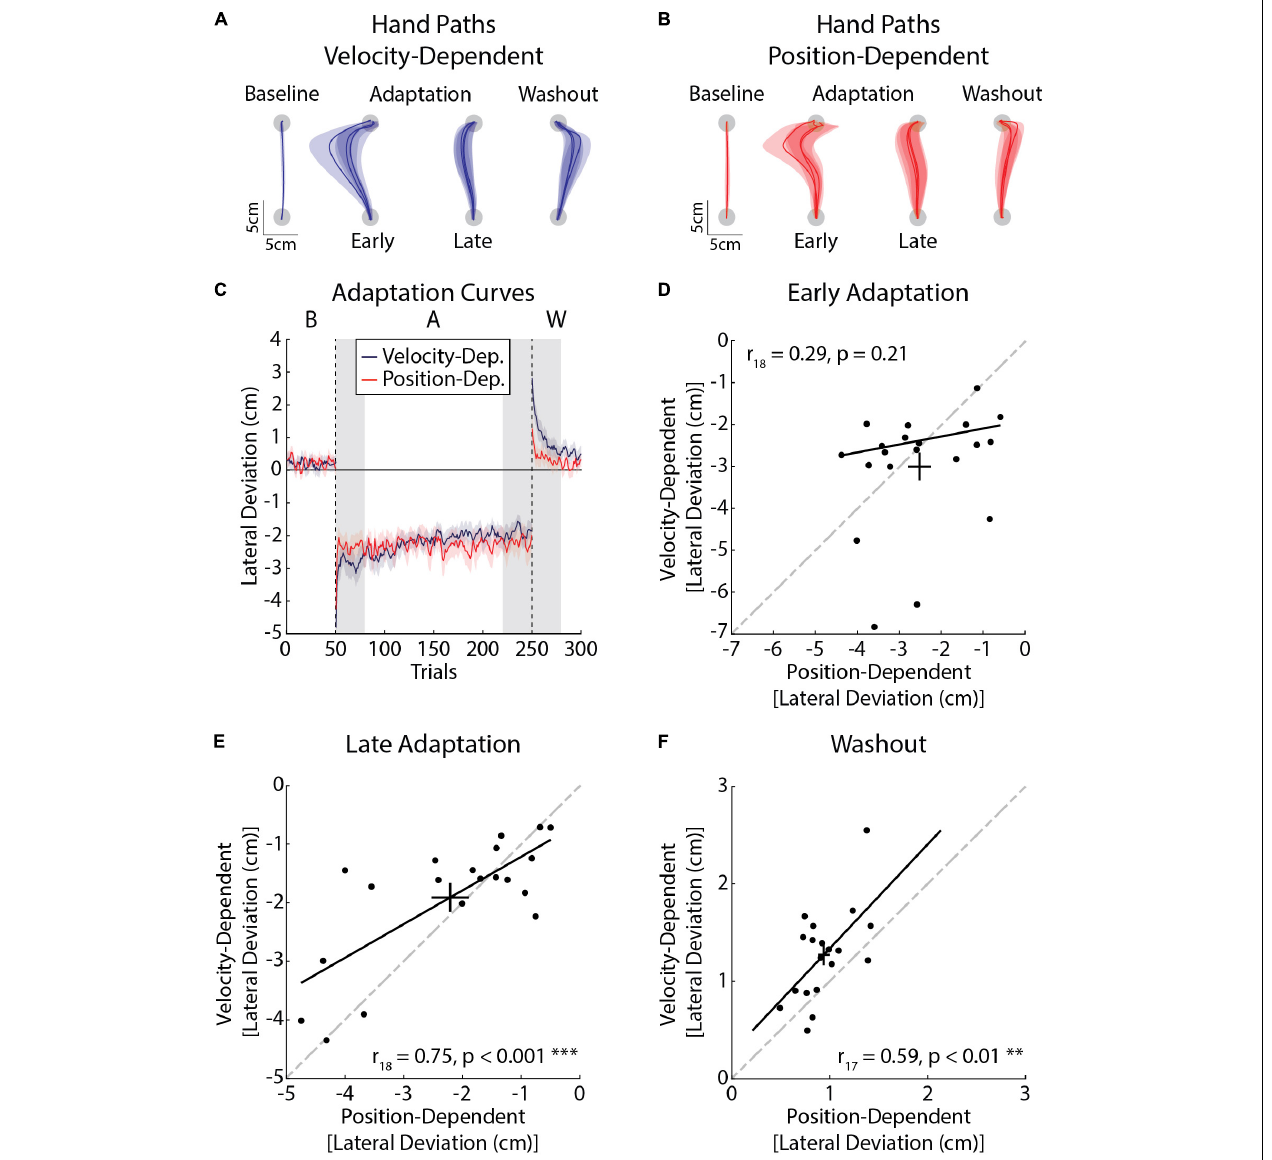
FIGURE 6 | Kinematic differences in adaptation in velocity- (blue) and position-dependent (red) force fields ( Experiment 2a ). (A) Average hand paths from the velocity-dependent force field. Hand paths were averaged across the baseline phase. The first and last three trials of the adaptation phase were averaged across participants. Similarly the first three trials of the washout phase were averaged across participants. (B) Average hand paths from the position-dependent force field. Hand paths are presented in the same manner as panel (A) . (C) Peak lateral deviations throughout the experiment ( n = 20, 10 female). Solid lines represent the group mean and surrounding shaded regions represent the SEM. Individual differences in adaptation were measured in Early Adaptation , Late Adaptation , and Washout (shaded gray regions). (D) Average peak lateral deviations measured in Early Adaptation in each task. Peak lateral deviations for the position-dependent forces are plotted on the x -axis and peak lateral deviations for the velocity-dependent forces are plotted on the y -axis. Error bars represent the mean and SEM. The trendline was obtained via robust linear regression and is used for visualization purposes. The dashed line represents unity. (E) Average peak lateral deviations measured in Late Adaptation . (F) Average peak lateral deviations measured in Washout . Results in panels (E,F) are presented in the same format as panel (D) . ∗∗ p < 0.01 and ∗∗∗ p < 0.001 after Bonferroni corrections (corrected for 3 comparisons).